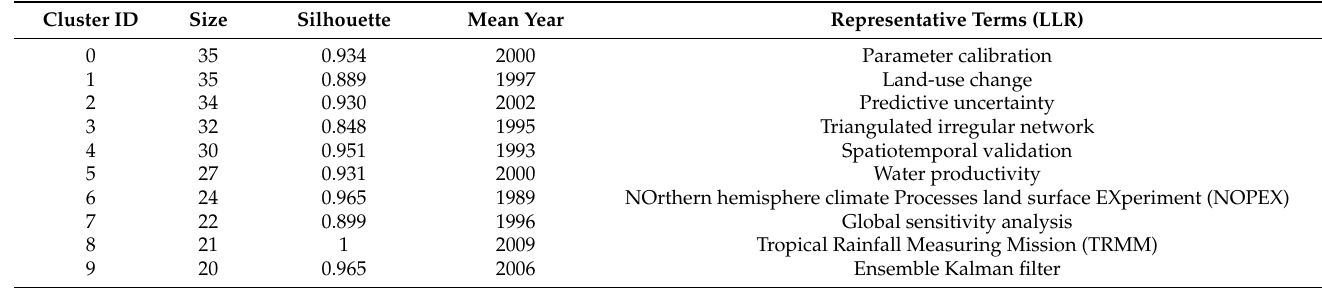
Table 3. Top ten most highly cited documents in the research field of distributed hydrological models. Ranking